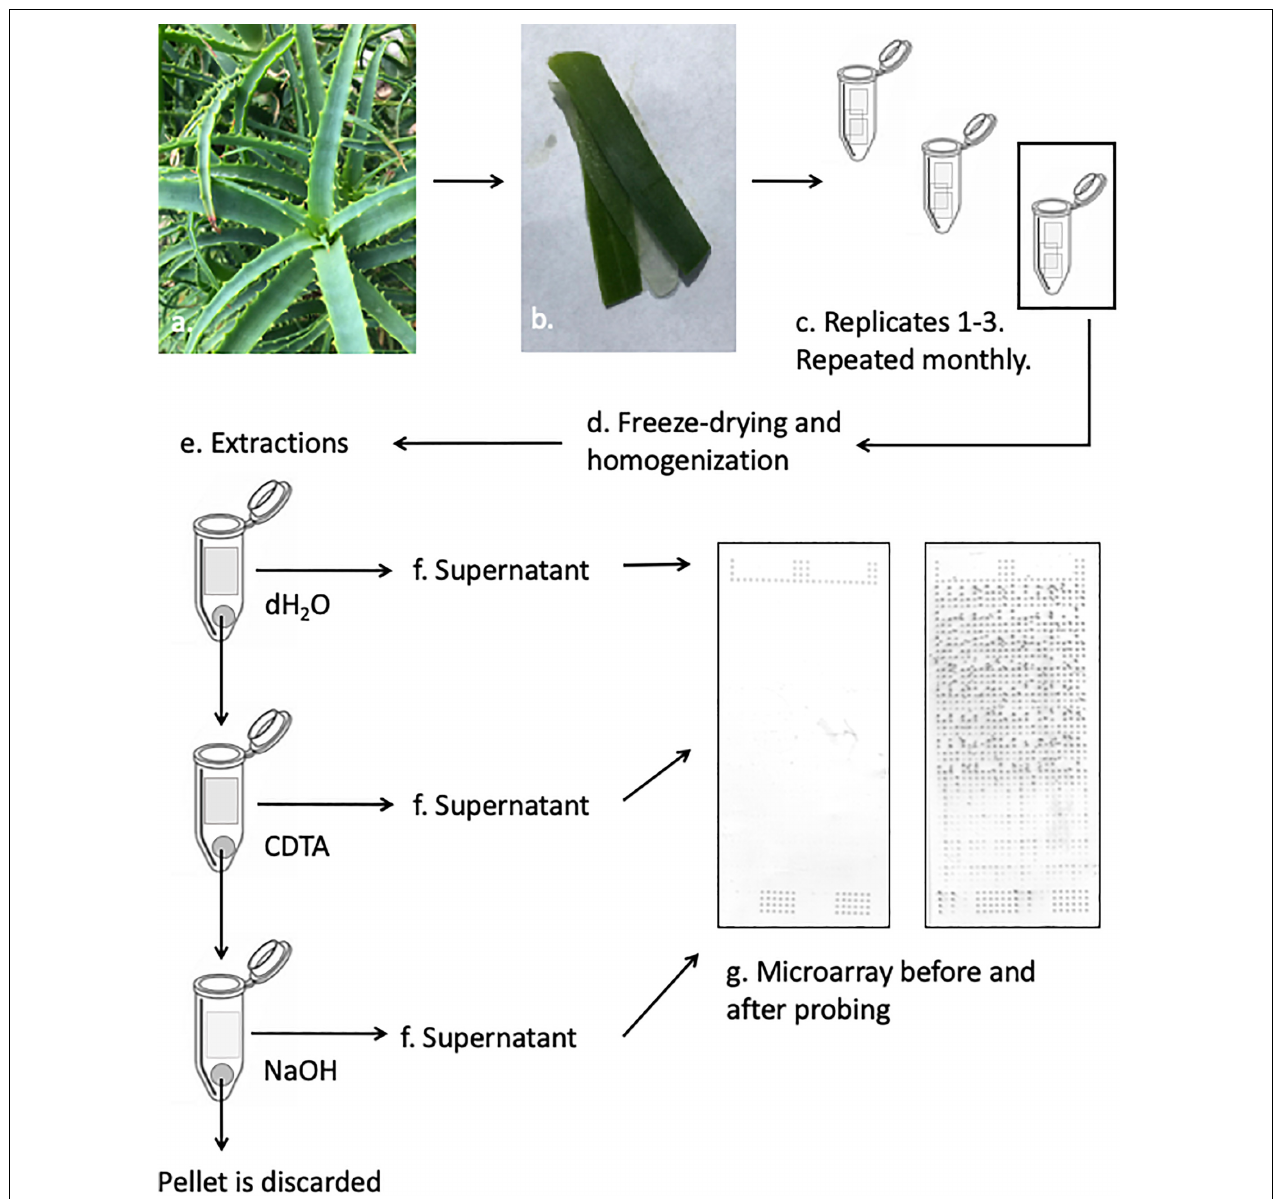
FIGURE 1 | Schematic presentation of the CoMPP method illustrated with Aloe arborescens . Species are sampled in triplicates and prepared for extractions. The supernatant from each sequential extraction step is printed separately in technical replicates on nitrocellulose membranes. The printed microarrays are then probed with a selection of molecular